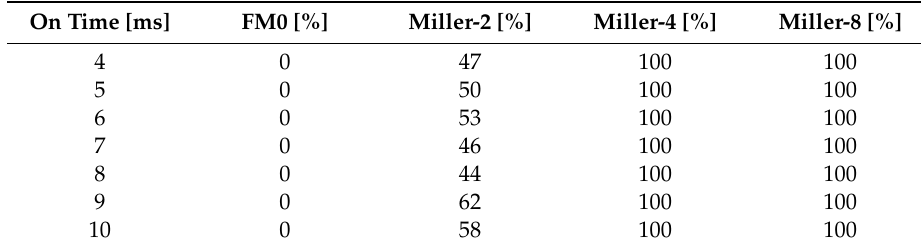
Table 1. Percentage of recorded readings for each encoding typology and activation time, using a type-A reference interval (Tari) value of 6.25 µ